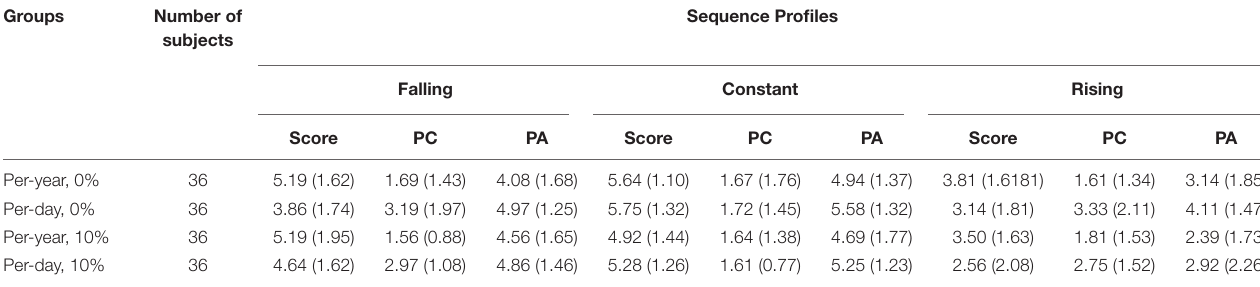
TABLE 1 | Means of evaluations.